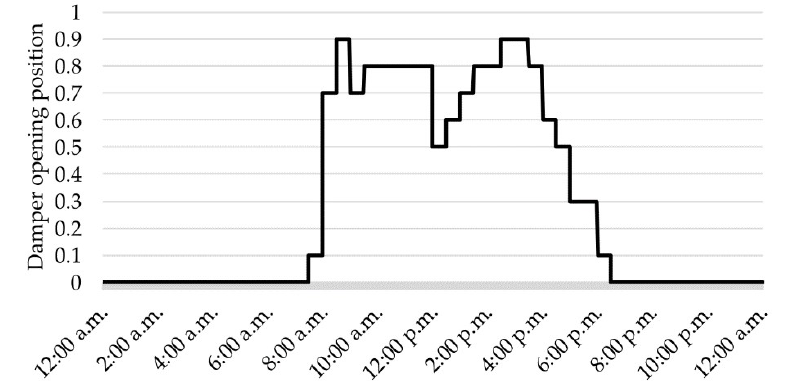
Figure 5. Schedule for Wednesday, classrooms in a normal school week, based on damper positions.